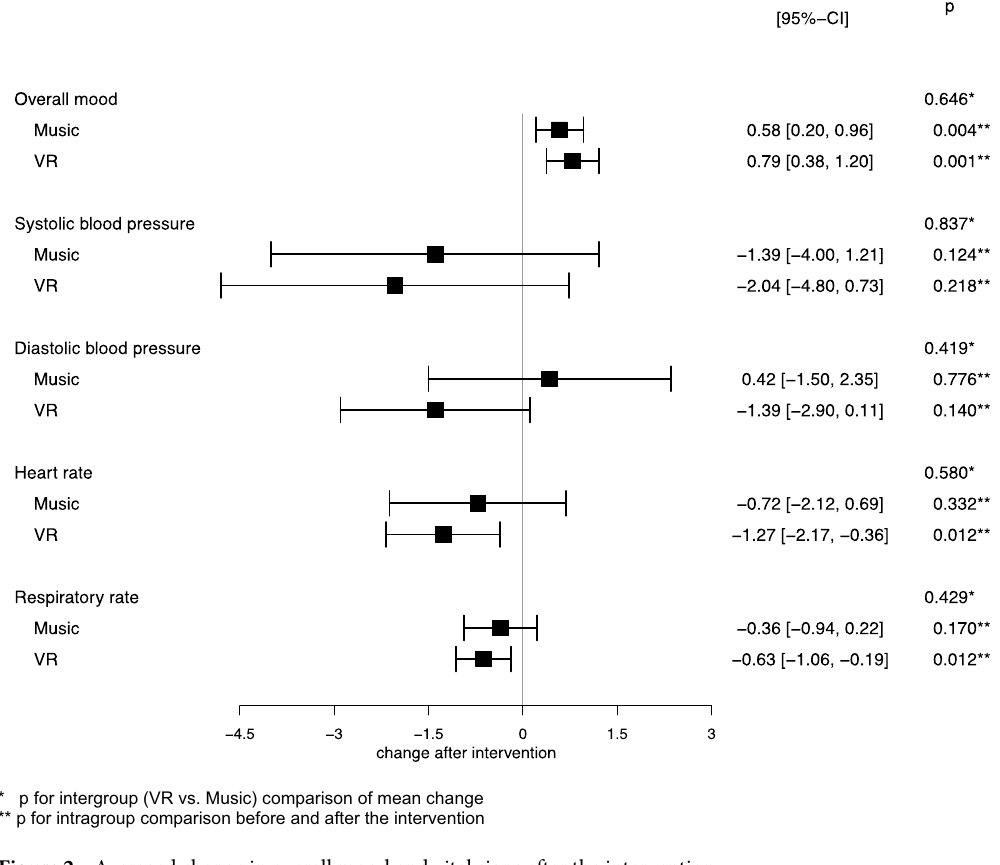
Figure 2. Averaged change in overall mood and vital signs after the